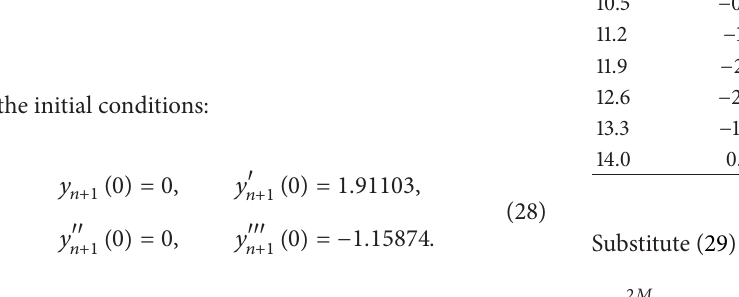
Figure 4: Solution by RK method (RK Solution) at 𝛼 = 2 and solution by Haar wavelet-quasilinearization technique (HAAR Solution) at 𝐽 = 5 and different values of 𝛼 for 𝑎 = 1 , 𝜇 = 0.1 , 𝑏 = 0.01 , and 𝑓 = 0 .